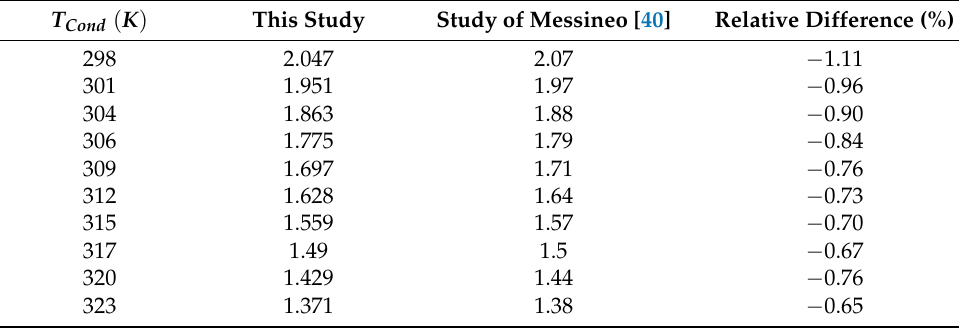
Table 5. Validation results in terms of COP for different T Cond